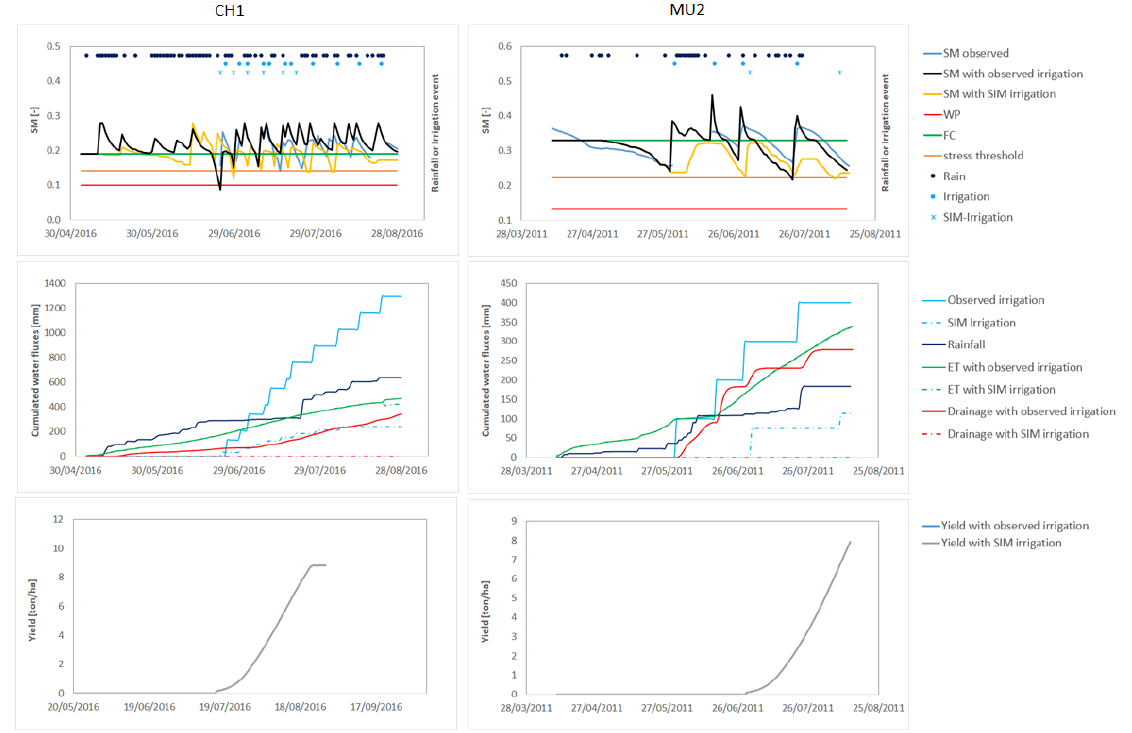
Figure 7. Comparison of water fluxes and yield for observed and SIM irrigation for the Chiese (field CH1) and Muzza (field MU2) Consortia. Table 7. SIM strategy application in the Chiese and Muzza Irrigation Consortia.